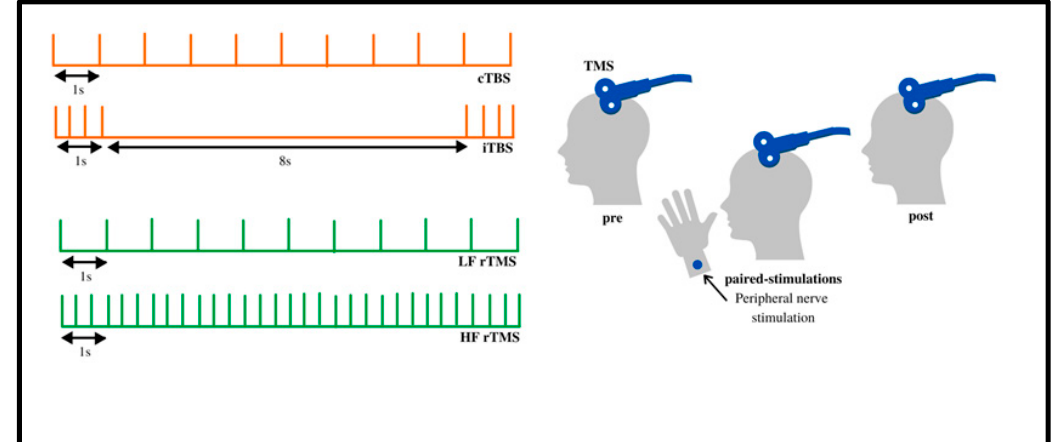
Figure 2. Continuous, repetitive, and intermittent TMS: The various protocols can be classified into continuous theta burst stimulation (cTBS) and intermittent theta burst stimulation (iTBS). In cTBS, three pulses are given at 50 Hz with an inner frequency of 5 Hz for either 20 or 40 s. iTBS consists of 20 bursts every 2 s at 0.1 Hz. iTBS is considered to be excitatory, while cTBS is considered to be inhibitory. Adapted from Klomjai et al. [24].